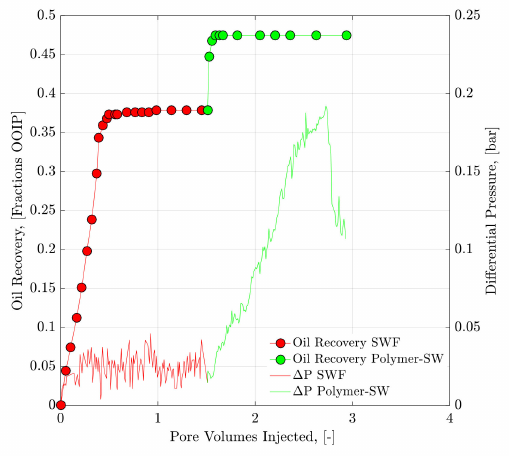
Figure 12. Oil recovery and pressure drop versus PV injected for Bent 5.3 core plug. Red color represents the experimental data for secondary-mode injection of smart water flood while green color is for the tertiary injection mode of